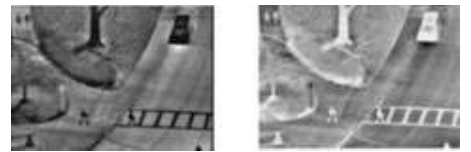
Figure. 18. Repeating steps 2 and 3 for a sample of test images.